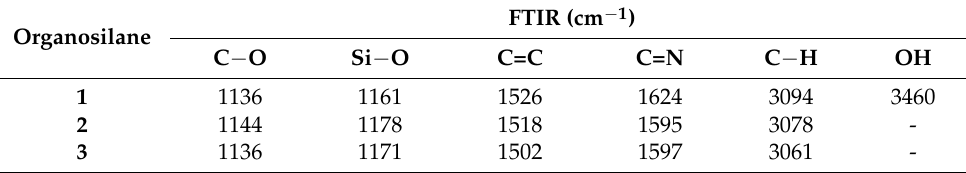
Table 2. Some common Fourier-transform infrared (FTIR) data for organosilanes 1 – 3